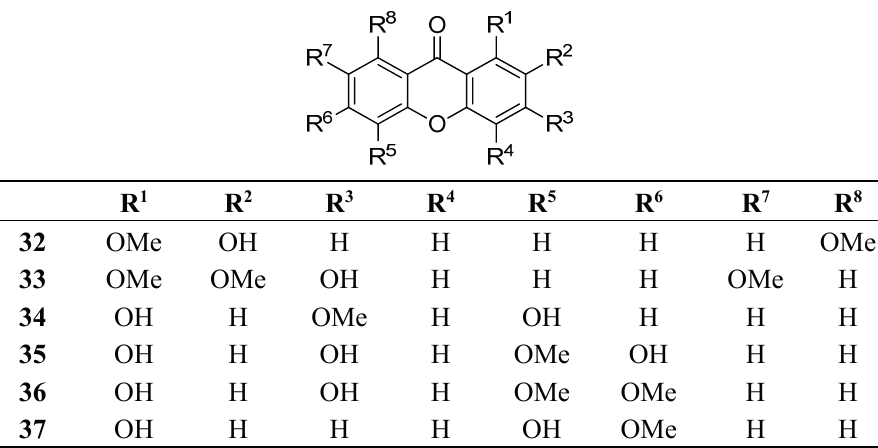
Figure 2. Chemical structures of tested dioxygenated xanthones.